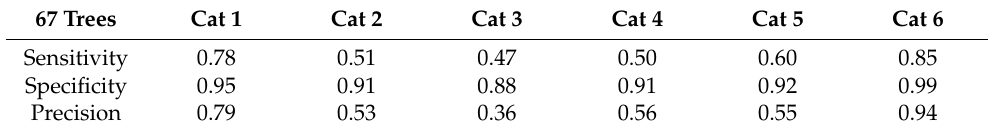
Table 2. Results of the comparison of visual observation to the model. It shows the sensitivity, speci- ficity and the precision for each category. Six test subjects got patches of trees, 10 to 13 per category. 67